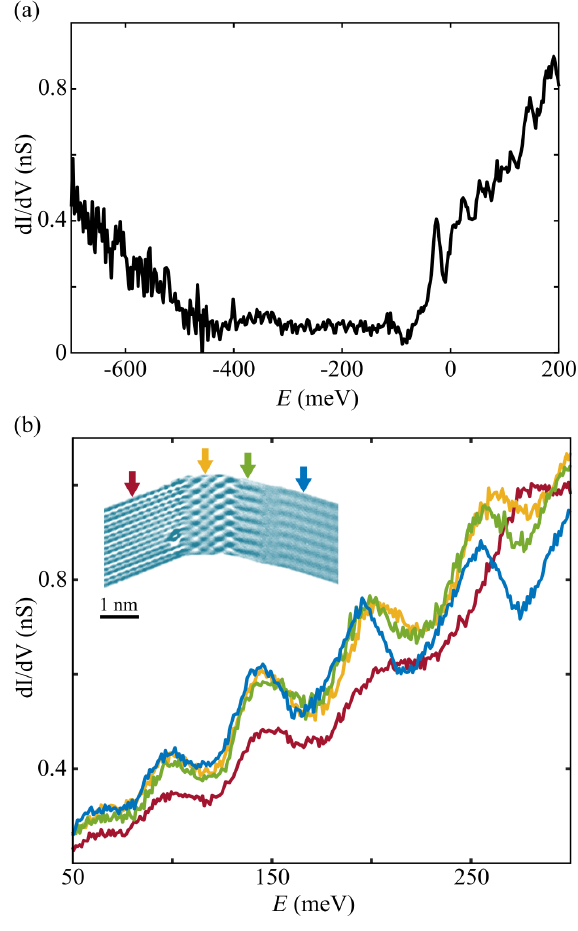
FIG. 9. (a) Electronic spectrum of InAs nanowire. E about 75 meV above the conduction-gap minimum, and the semiconducting gap is about 350 meV. Resonances indicating that the 1D subbands are seen in both the conduction and valance bands. (b) van Hove singularities from spectra taken on different crystal terminations. Locations across the nanowire are shown in the inset by arrows of corresponding color over the